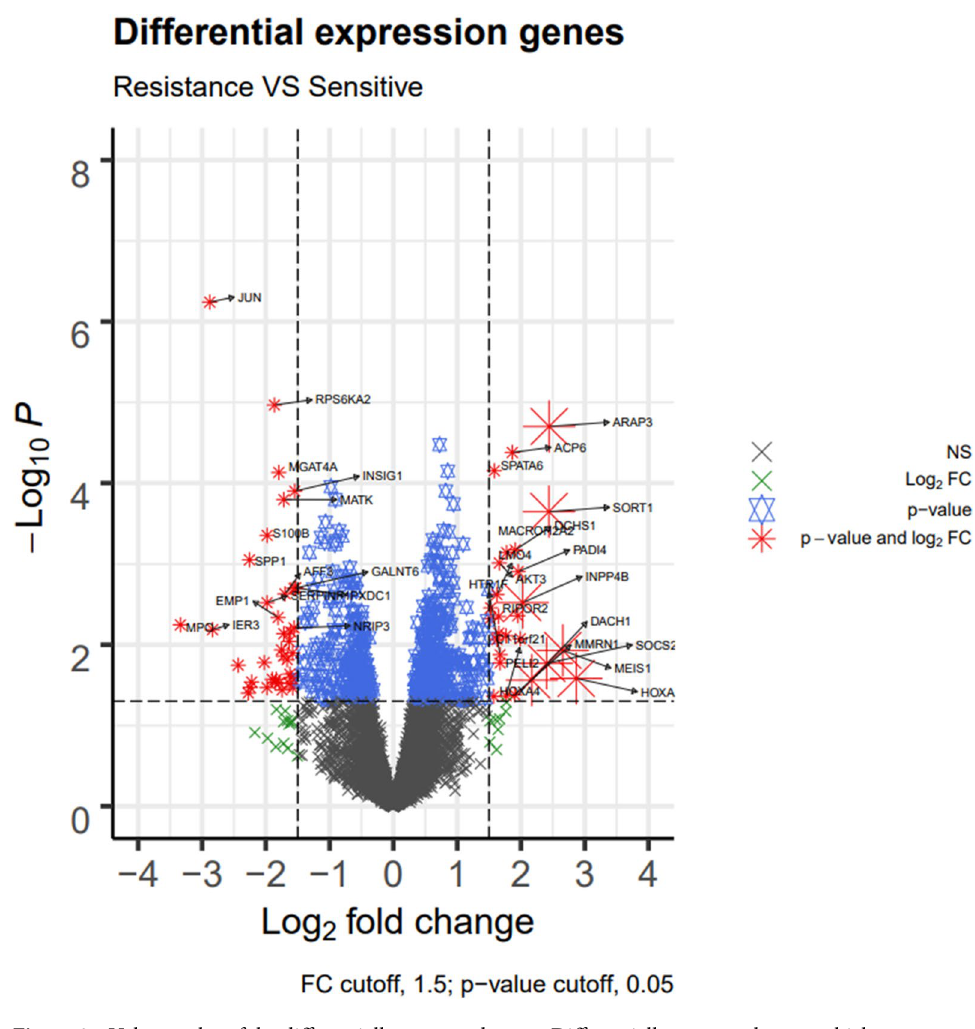
Figure 3. Volcano plot of the differentially expressed genes. Differentially expressed genes which were identified by meta-analysis were illustrated using the ggplot2 package in R 74 . P value cutoff was 0.05. As presented, 34 genes were identified as common differentially expressed genes (DEGs) with more than 1.5 fold change in chemo-resistance group as compared to the chemo-sensitive group. The data presented as log2 fold change. The plot was created by the ggplot2 R package version 3.3.3 63 . FC fold change, NS not